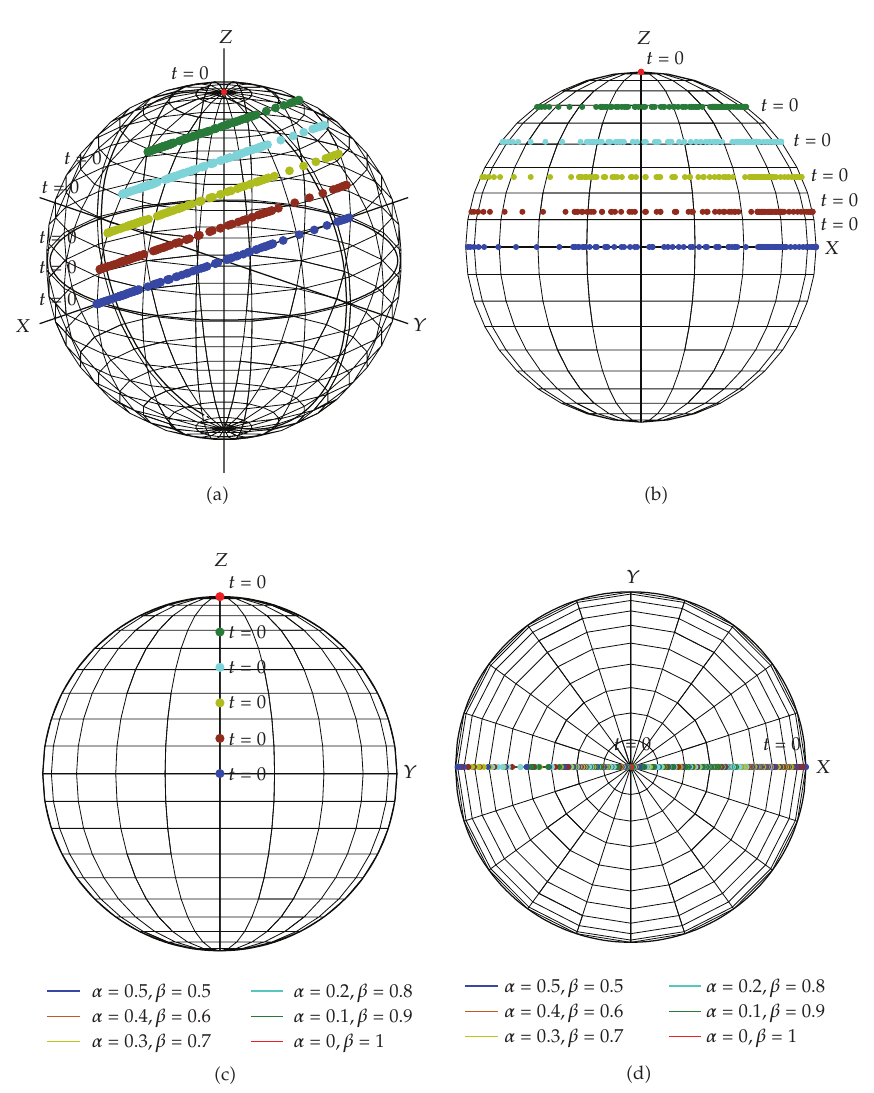
Figure 5: Excess electron spin dynamics on the bloch sphere for small Δ